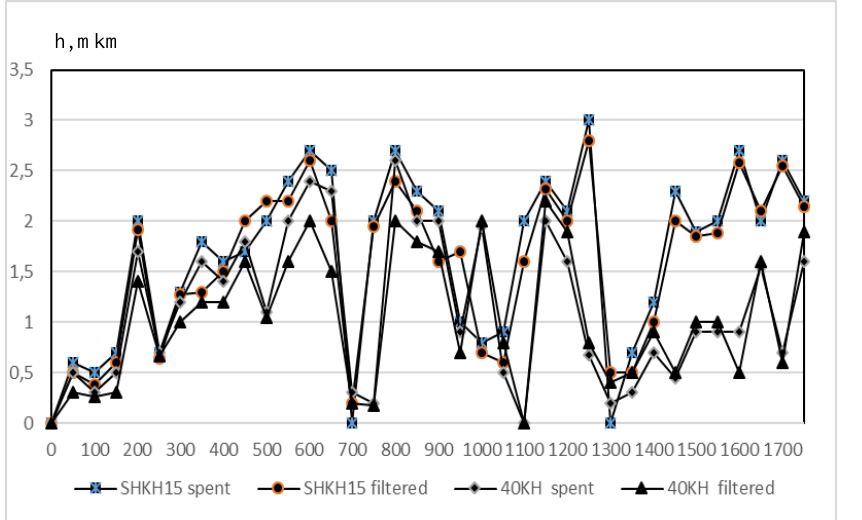
Fig. 4. Kinetics of changes in the thickness of the boundary adsorption films